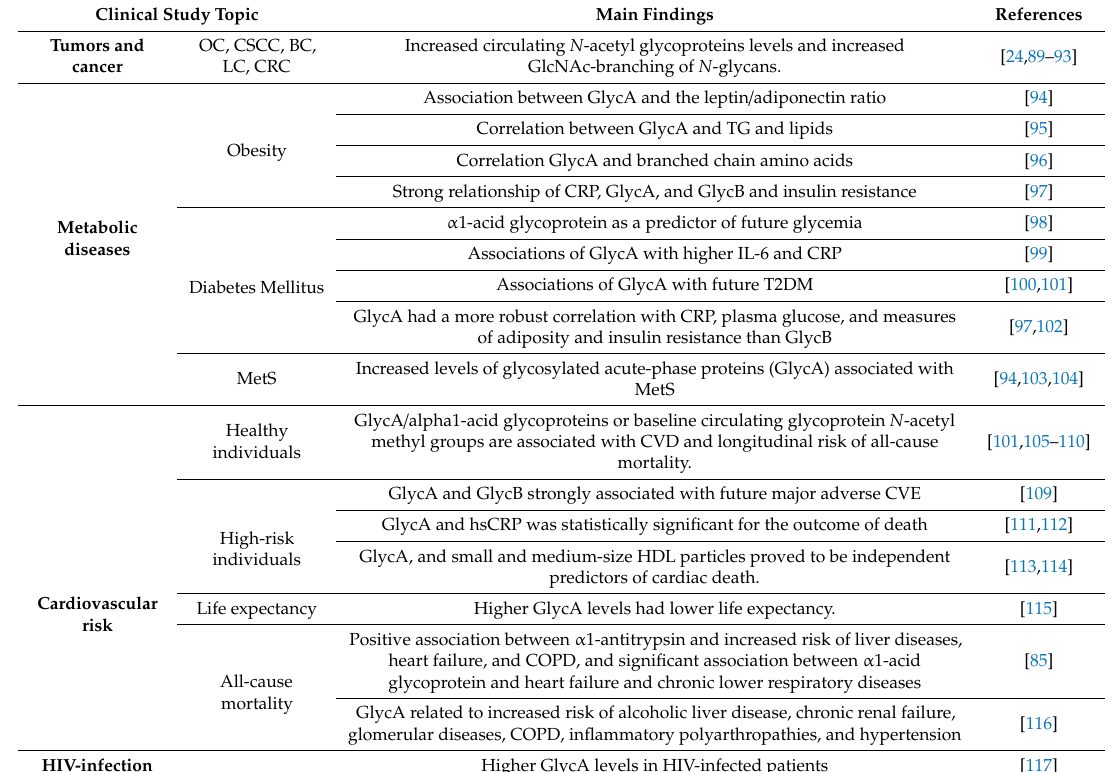
Table 2. Summary of 1 H-NMR glycoprotein’s clinical applications. (a) Diseases. Clinical Study